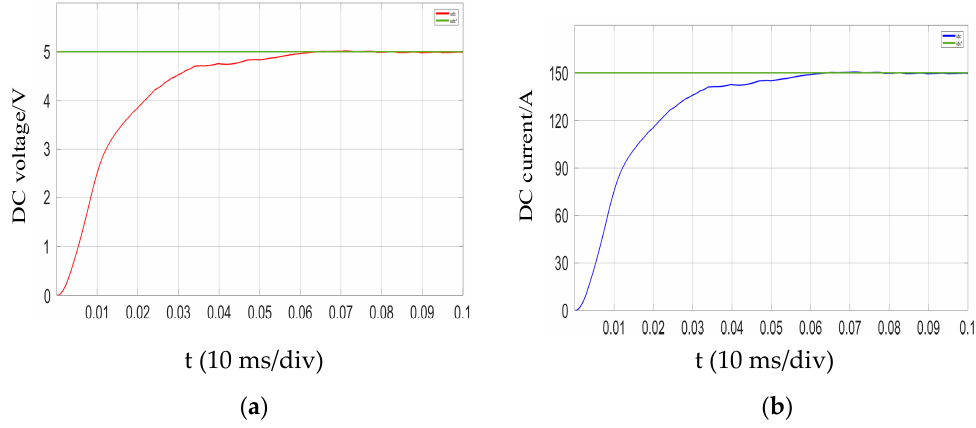
Figure 6. Startup response of DC output: ( a ) voltage waveform; ( b ) current waveform.